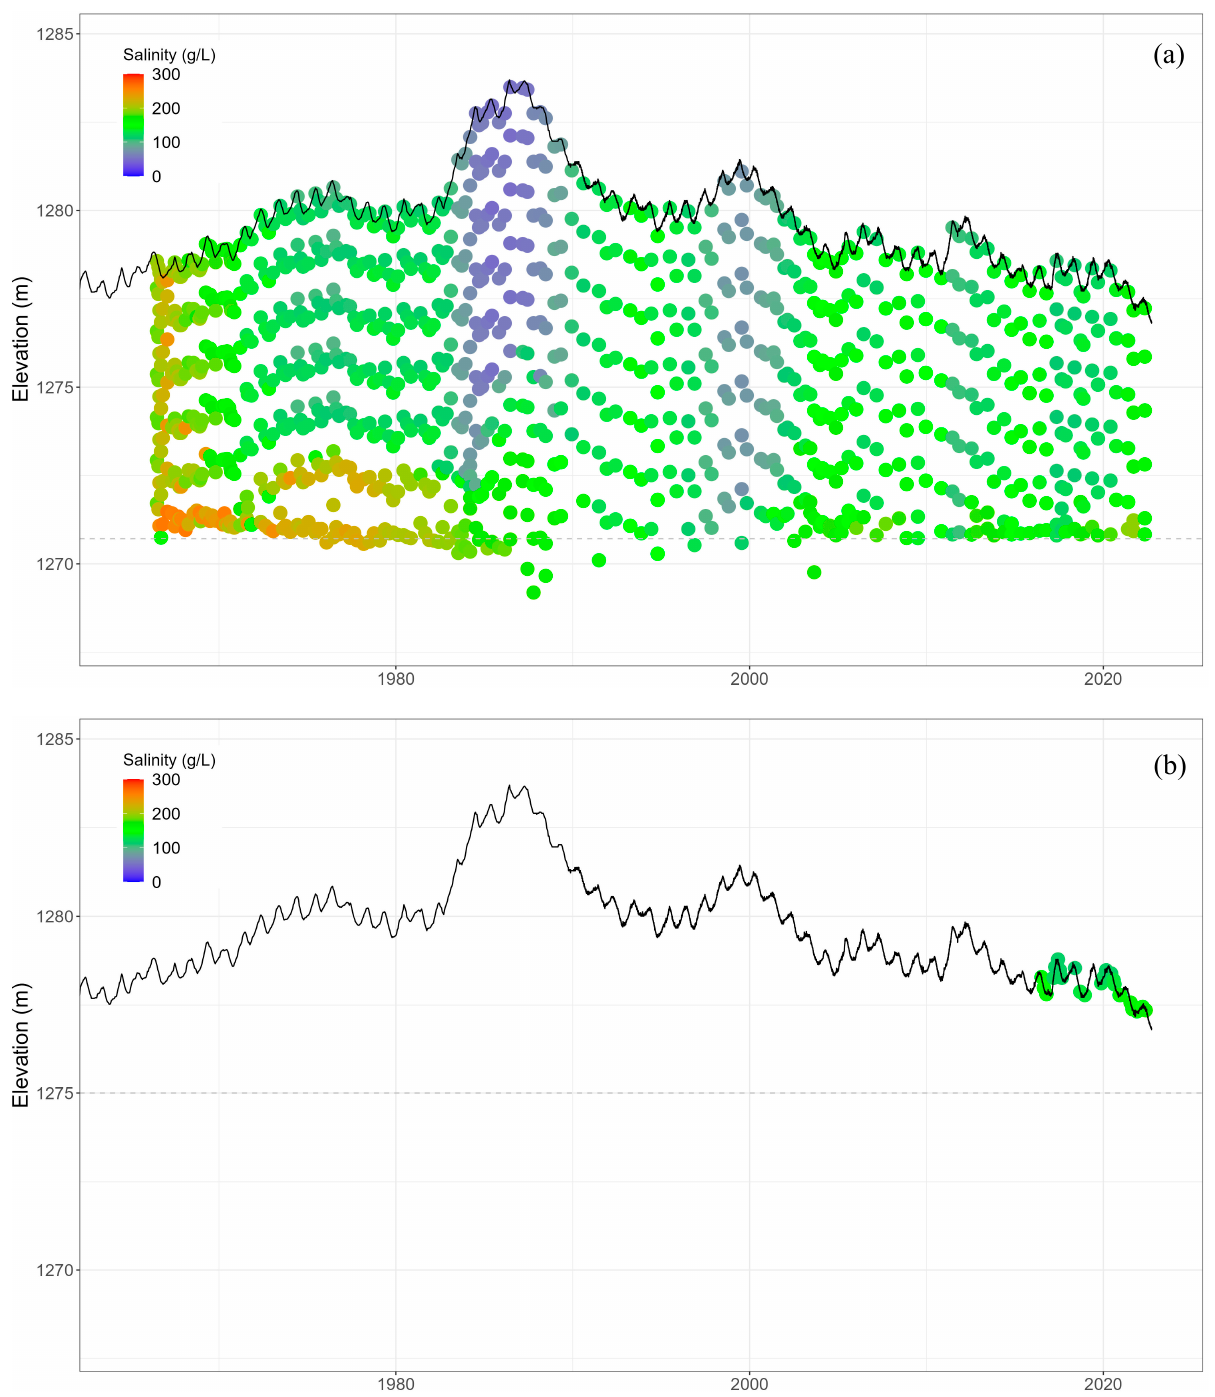
Figure 5. Example plots of salinity at depth over the period of record for individual sample sites ( a ) AS2 and ( b ) AIS, both of which are in the south arm (see Figure 1 for site locations). Each dot indicates a salinity calculation from a single sample site measurement. Salinity was calculated using the Naftz et al. [16] equation of state, Equation (1). Solid black line represents the WSE from USGS measurements. Dashed gray horizontal line represents the elevation of the bottom of the lake at the specific sample site. Due to drifting of the boat or instrument while being lowered into the water, some measurements have been recorded below the elevation of the lake bottom at the location of the measurement